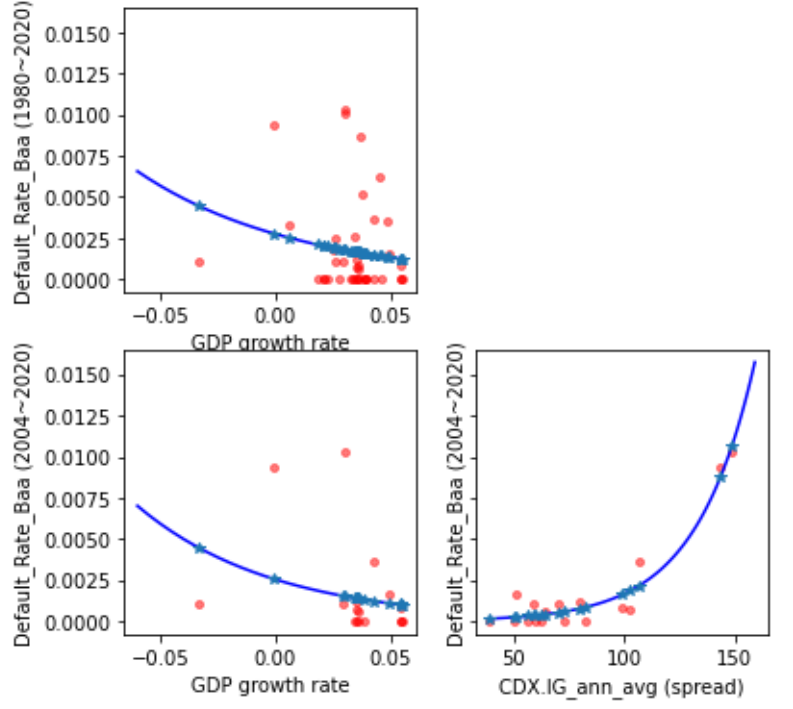
Figure 4. Rating Baa: Logistic regression of DR_Baa on ( a ) GDP with 1980–2020 data; ( b ) GDP with 2004–2020 data; ( c ) CDX.IG with 2004–2020 data (in spread).